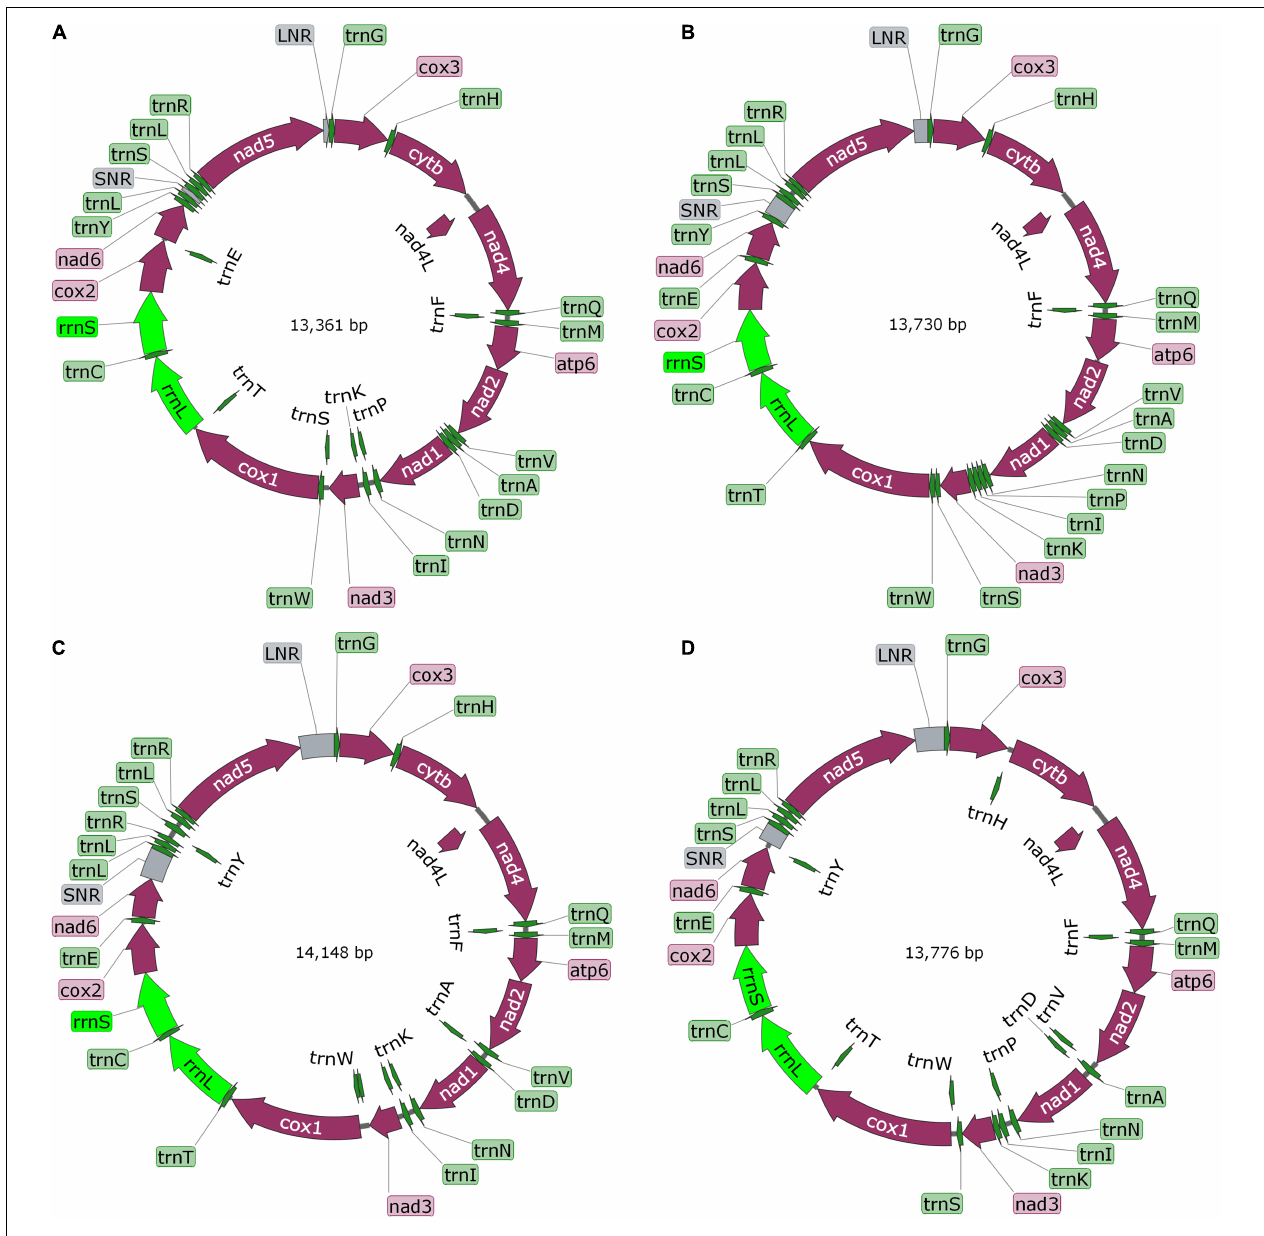
FIGURE 3 | The diagram of complete mitochondrial genome of Mesocestoides sp. RKZ08 (A) , Paranoplocephala sp. RKZ13 (B) , Hydatigera sp. XHPW10 (C) , and Mosgovoyia sp. SQ20 (D) . The protein-encoding genes are depicted in plum, the tRNAs are depicted in green, the rRNAs are depicted in light green and the non-coding mitochondrial regions (NCRs including LNR and SNR) are depicted in gray. The inferred gene boundaries of them are shown in Table 1